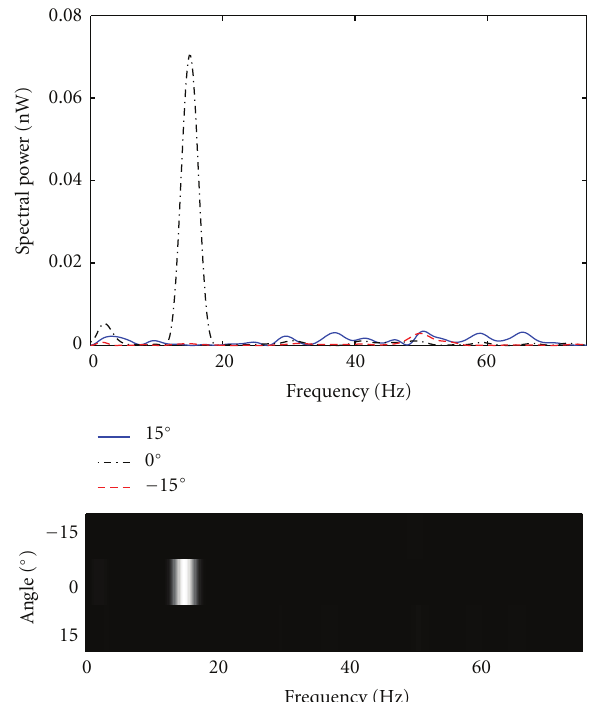
Figure 12: Spectrogram for a speaker at distance of 1.5 m, produc- ing a 15 Hz tone behind a closed door when the radar is deployed on the human body.